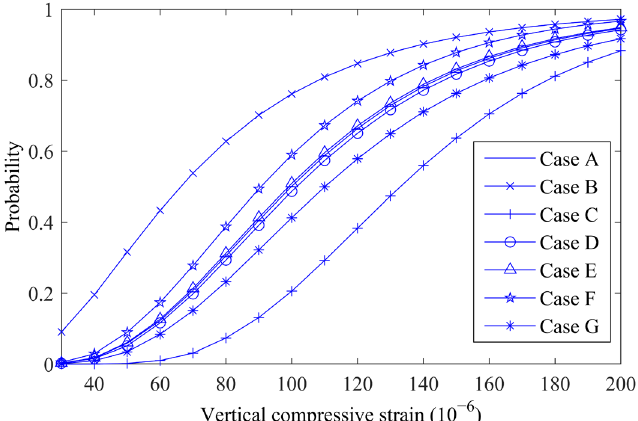
Figure 8. Results of the cumulative probability distributions of vertical compressive strain at B1 with the different mean values of load pressure, speed, and temperature of the asphalt layer.